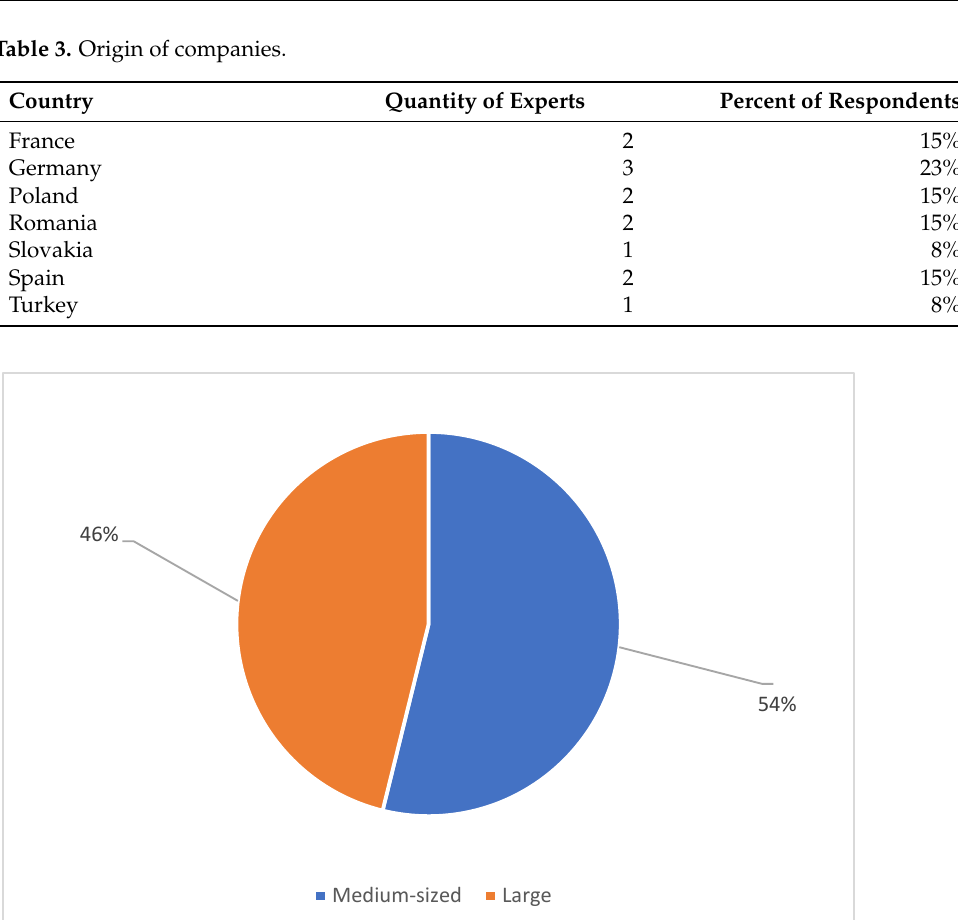
Figure 2. The size of the surveyed car-sharing companies.